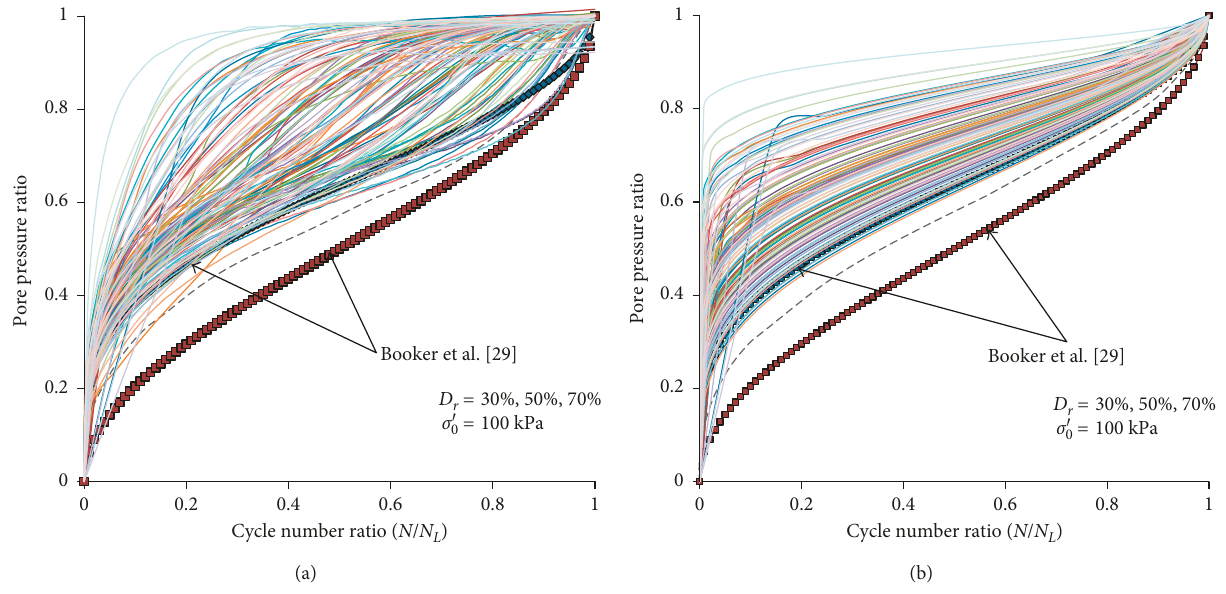
Figure 12: Pore-water pressure ratio (PWP) versus cycle ratio number ( N / N by using α coefficients from the model proposed by Booker et al.